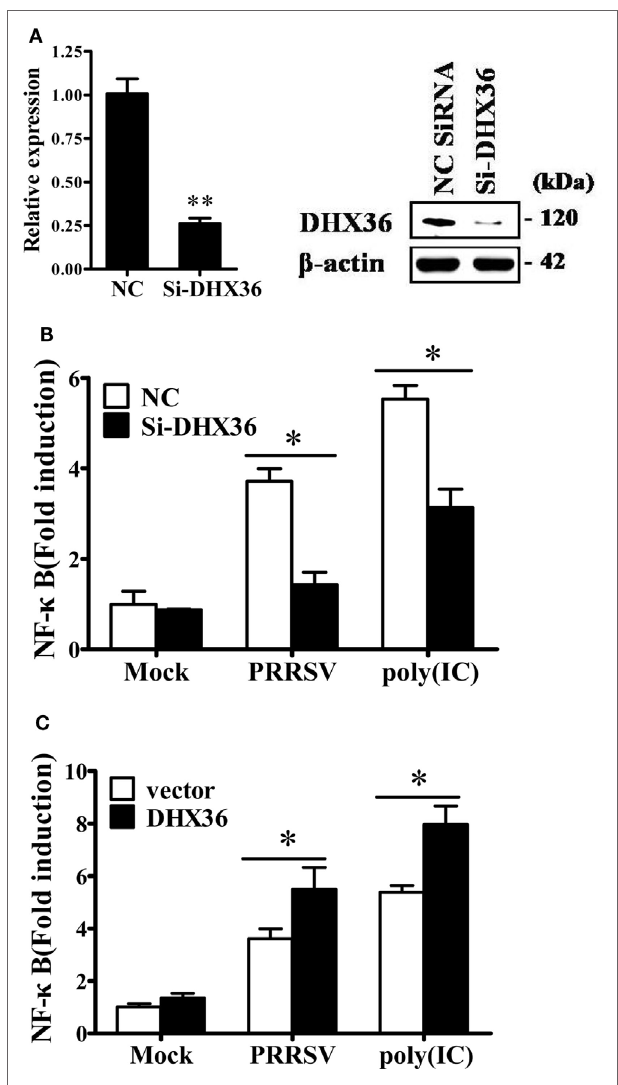
FigUre 3 | DExD/H-box helicase 36 (DHX36) is involved in porcine reproductive and respiratory syndrome virus (PRRSV)-induced NF- κ B activation in MARC-145 cells. (a) MARC-145 cells were transfected with small interfering RNA (siRNA)-targeting DHX36 or control siRNA. Thirty-six hours later, real-time RT-PCR and Western blot were performed to analyze the mRNA and protein expression of DHX36. (B) MARC-145 cells were co-transfected with the NF- κ B reporter plasmid, pRL-TK plasmid, along with the indicated siRNA. At 24 h after transfection, cells were stimulated by poly I:C (1 µg/ml) or infected with PRRSV (MOI = 1) for 24 h. Cells were then collected and lysed for dual-luciferase assay. (c) MARC-145 cells were transiently transfected with either DHX36 or control plasmid along with NF- κ B luciferase reporter plasmid. At 36 h post-transfection, cells were stimulated with mock, PRRSV (MOI = 1) or poly I:C (1 µg/ml, transfected with Lipofectamine) followed by luciferase assay.